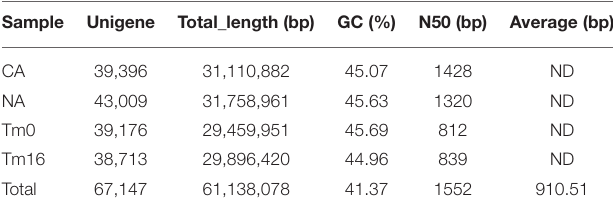
TABLE 1 | Statistics of assembly of T. chinensis